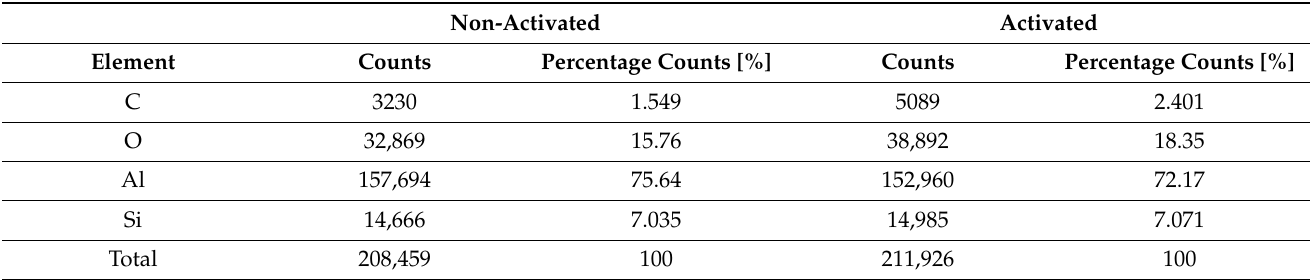
Table 1. Results of EDS scan over the surface visible in Figure 6a,b.